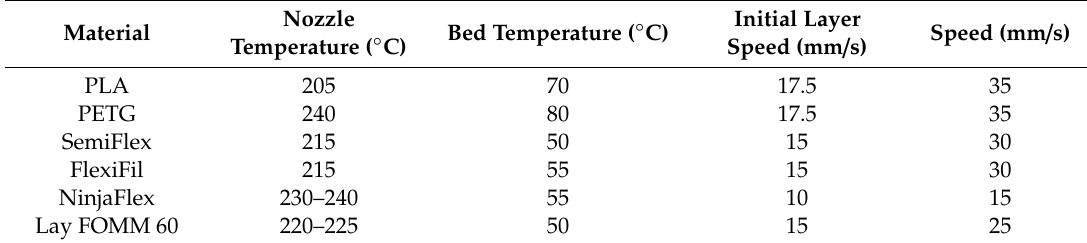
Table 2. Printing parameters of all materials.